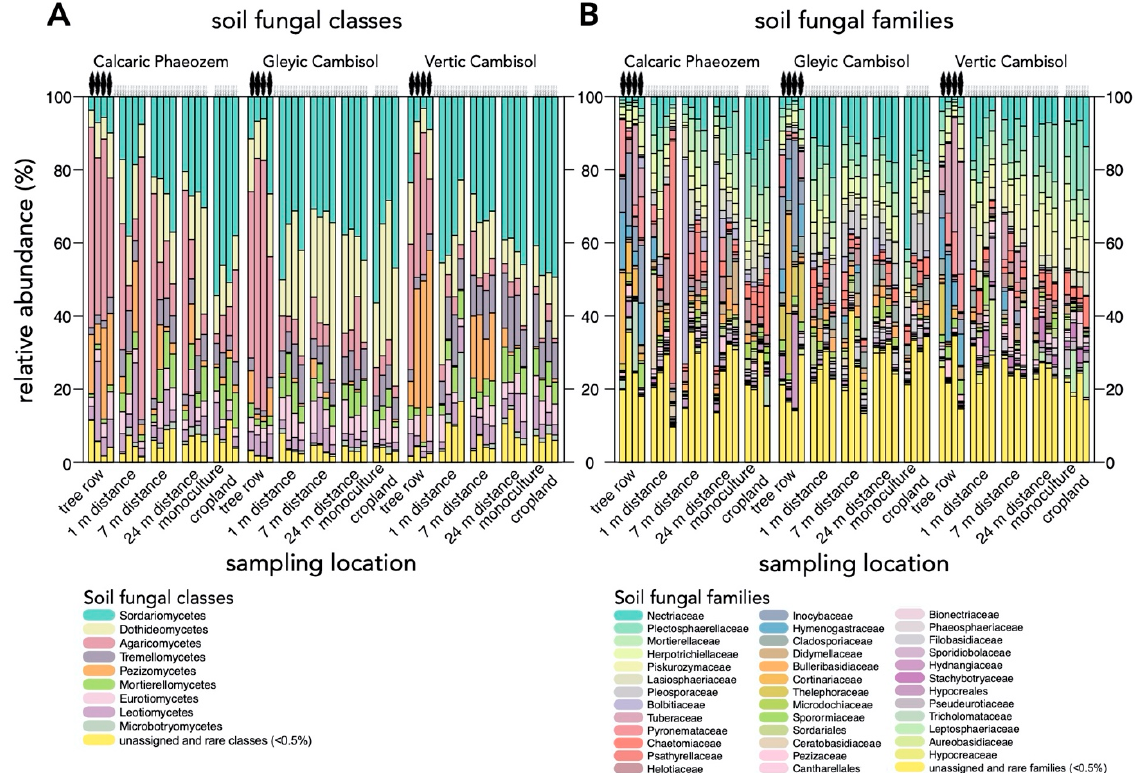
Figure 3. Relative abundance of dominant (>0.5%) soil fungal ( A ) classes and ( B ) families in in paired temperate agroforestry and monoculture cropland systems. Stacked bars represent individual samples. Soil samples within each replicate plot of the temperate agroforestry croplands were collected in the centre of the tree row as well as in the crop row at 1, 7, and 24 m distance from the trees in order to cover the spatial heterogeneity of the systems. In the monoculture croplands, soil samples were collected in the centre of each replicate plot.